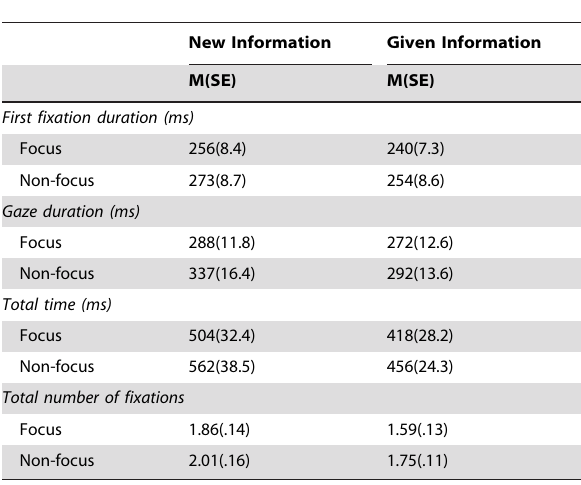
Table 2. Eye Movement Measures for the Target Region. Table 3. Eye Movement Measures for the Post-target